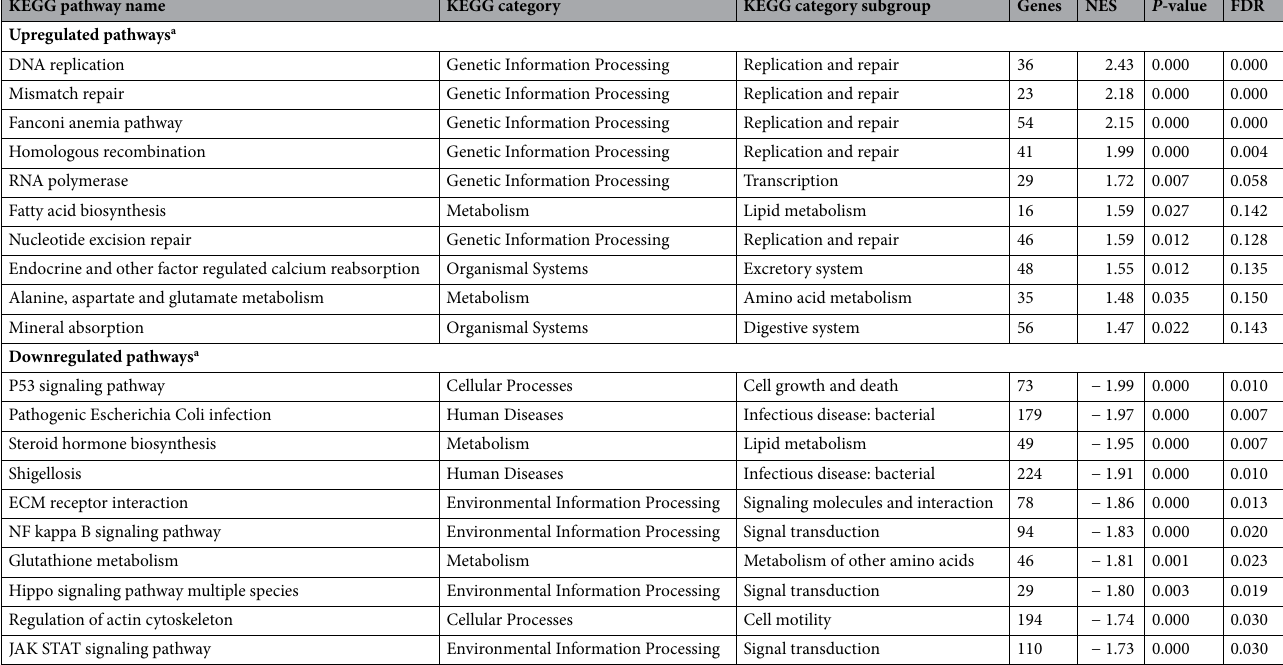
Table 3. Top 10 most enriched (based on NES) up- and downregulated pathways related to the intestine in induced pluripotent stem cell derived intestinal epithelial cell layers exposed to 10 mM butyrate compared with the control. a References indicating their role or relationship to the intestine for the selected pathways are given in the supplementary files; Table S1.